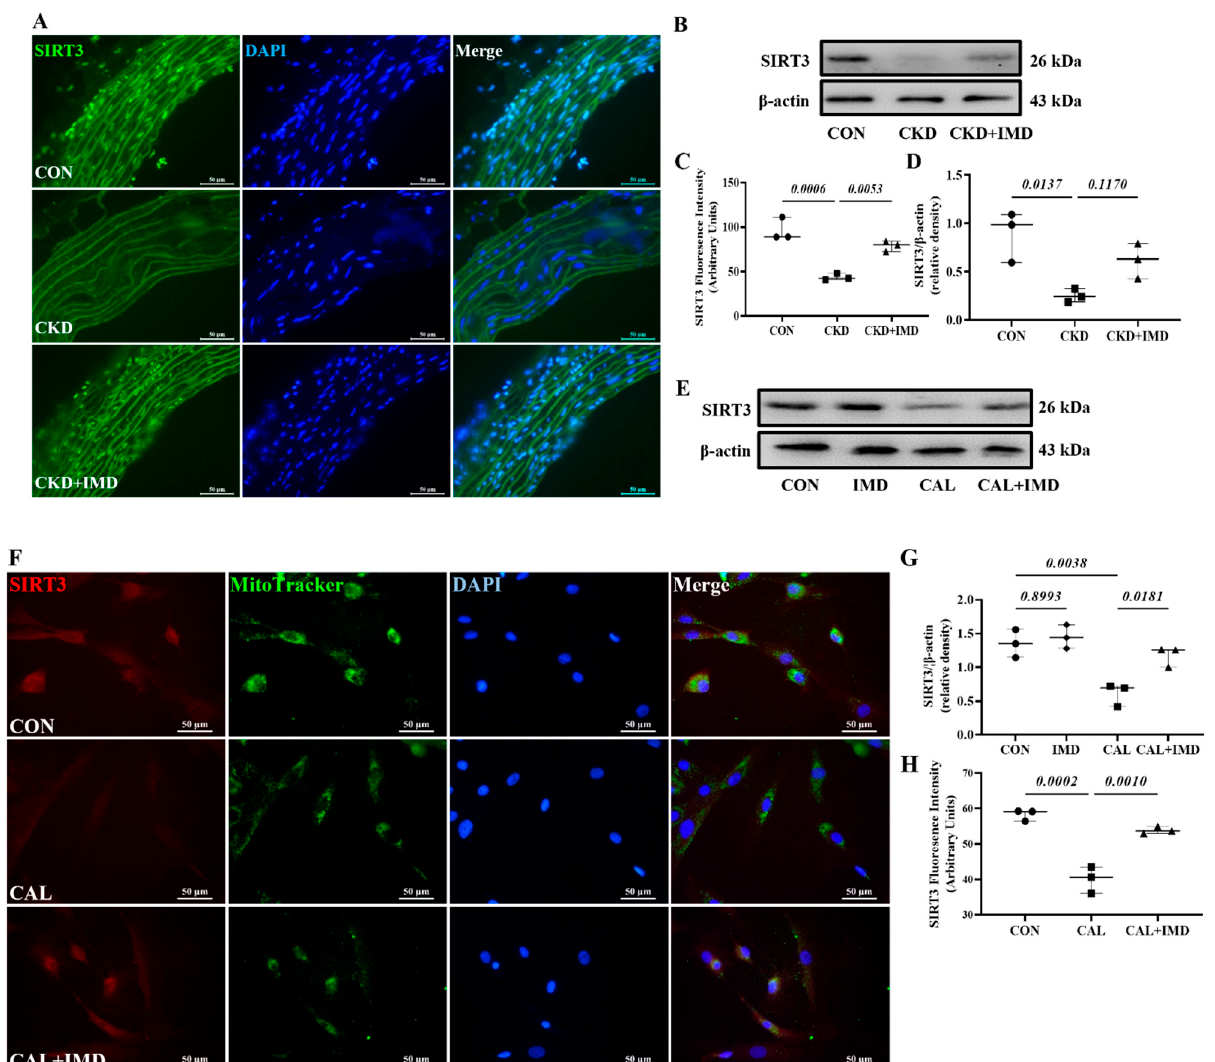
Figure 3. IMD upregulated Sirt3 in the calcified aortas of CKD rats and calcified VSMCs. ( A ) Immunofluorescence staining for Sirt3 (green) in rat aortas. Nuclei were stained with DAPI (blue). Merged images are shown (Scale bar = 50 µ m). ( C ) Average fluorescence intensity of Sirt3 in rat aortas ( n = 3). ( B ) Western blot analysis of protein levels of Sirt3 in rat aortas and ( D ) quantification ( n = 3). ( E ) Western blot analysis of protein levels of Sirt3 in rat VSMCs and ( G ) quantification ( n = 3). ( F ) Immunofluorescence staining for Sirt3 (green) in rat VSMCs. Mitochondria were stained with MitoTracker (green). Nuclei were stained with DAPI (blue). Merged images are shown (Scale bar = 50 µ m). ( H ) Average fluorescence intensity of Sirt3 in VSMCs ( n = 3). CON (circles): control rats or VSMCs, CKD (squares in ( C , D ): CKD vascular calcification rats, CKD + IMD (triangles in ( C , D )): CKD vascular calcification rats with IMD 1-53 treatment, IMD (diamonds in ( G )): control VSMCs with IMD 1-53 treatment, CAL (squares in ( G , H )): calcification VSMCs, CAL + IMD (triangles in ( G , H )): calcification VSMCs with IMD 1-53 treatment. Data are mean ± SD.